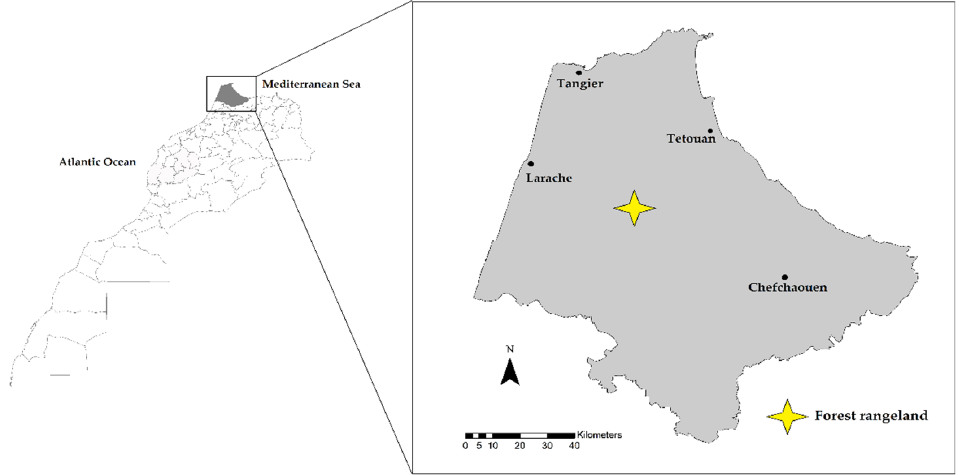
Figure 1. Location of the studied forest rangeland (northern